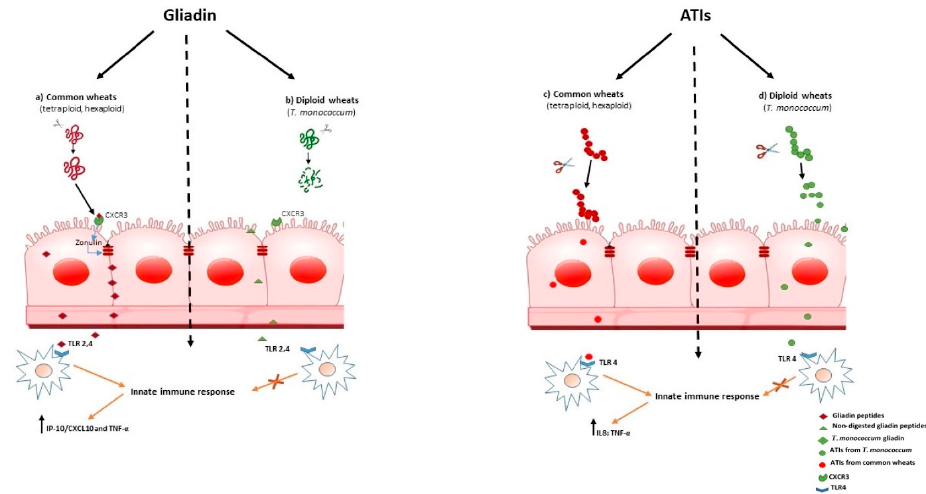
Figure 1. Schematic drawing that shows what happens in subjects with non-coeliac wheat sensitiv- ity on T. monococcum based diet containing common wheat, according to our hypothesis. ( a ) Inter- actions between non-digested gliadin peptides from common wheat and CXCR3 receptors in the intestinal epithelium trigger zonulin, release that leads to increased intestinal permeability. There- fore, non-digested gliadin peptides can reach the lamina propria and could activate the innate im- mune system via TLR-2 and TLR-4 receptors, inducing the release of pro-inflammatory cytokines; ( b ) As T. monococcum gliadin have a marked susceptibility to gastro-intestinal digestion, it can be hypothesized that such a mechanism, triggered by non-digested gliadin from common wheats, may not be elicited. Amylase trypsin inhibitors (ATIs) have been shown to be potent activators of the innate immune system in NCWS subjects. ( c ) ATIs from common wheats pass the intestinal epithe- lium and in LP stimulate TLR4 on macrophages, inducing the production of innate cytokines; ( d ) Considering that T. monococcum contains ATIs with a higher digestibility than modern wheat, the innate immune response could be prevented. Therefore, TM could retain a lower immunostimulat- ing activity for subjects suffering from NCWS. Therefore, since both innate and adaptive immunity are involved in CD pathogenesis, cereal suitable for a CD diet should be low in both classes of peptides. Among candidates, there are diploid wheat species, because of a reduced number of stimulatory epitopes of T-cell lines [46], and of the lack of a D-genome encoding the immunodominant 33-mer fragment [47], compared to common wheat. Triticum aestivum has evolved from hybridization between the tetraploid species Triticum turgidum (AABB) and the diploid species Aegilops tauschii (DD) [47]. Due to its “simpler” genome with respect to Triticum aestivum and durum , T. monococcum contains a reduced number of epitopes and toxic peptides [48]. These findings may have implications for programs aiming to produce wheat species with no or low contents of gluten proteins, harmful to CD patients. Nevertheless, even if it should prove impossible to generate a wheat cultivar completely devoid of harmful proteins, a cultivar low in T- cell stimulatory sequences can possibly be tolerated by most CD patients. Moreover, the difference in gluten composition among diploid (AA), tetraploid (AABB) and hexaploid (AABBDD) wheat varieties may affect the resistant to cleavage by intestinal peptidases [49]. We have previously investigated, in in vitro models, the immunological properties of gliadin protein from two monococcum cvs , Monlis and Norberto-ID331, in view of their possible use in CD patients [50]. We found that partially digested gliadin proteins extracted from both monococcum lines, Monlis and Norberto-ID331, induced